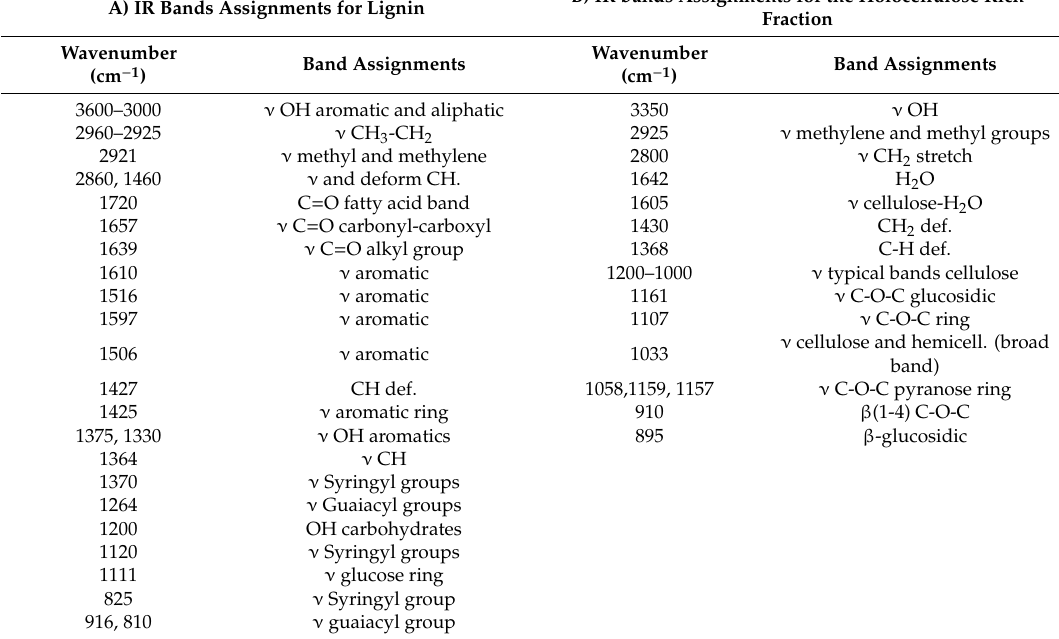
According to the FT-IR spectra, di ff erences between lignin (Figure 3, black line) and